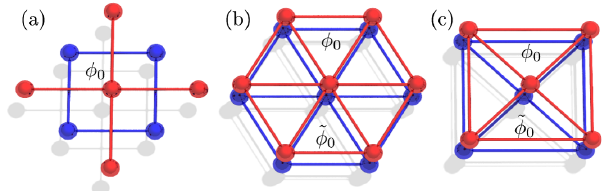
FIG. 6. Clusters used to estimate the error threshold for the depolarizing channel. The blue lines and triangles denote quenched random variables (cid:4) Z , and the red lines and triangles correspond to (cid:4) X . The central site is the spin variable summed over. The outer sites represent the spin variables fixed in the up